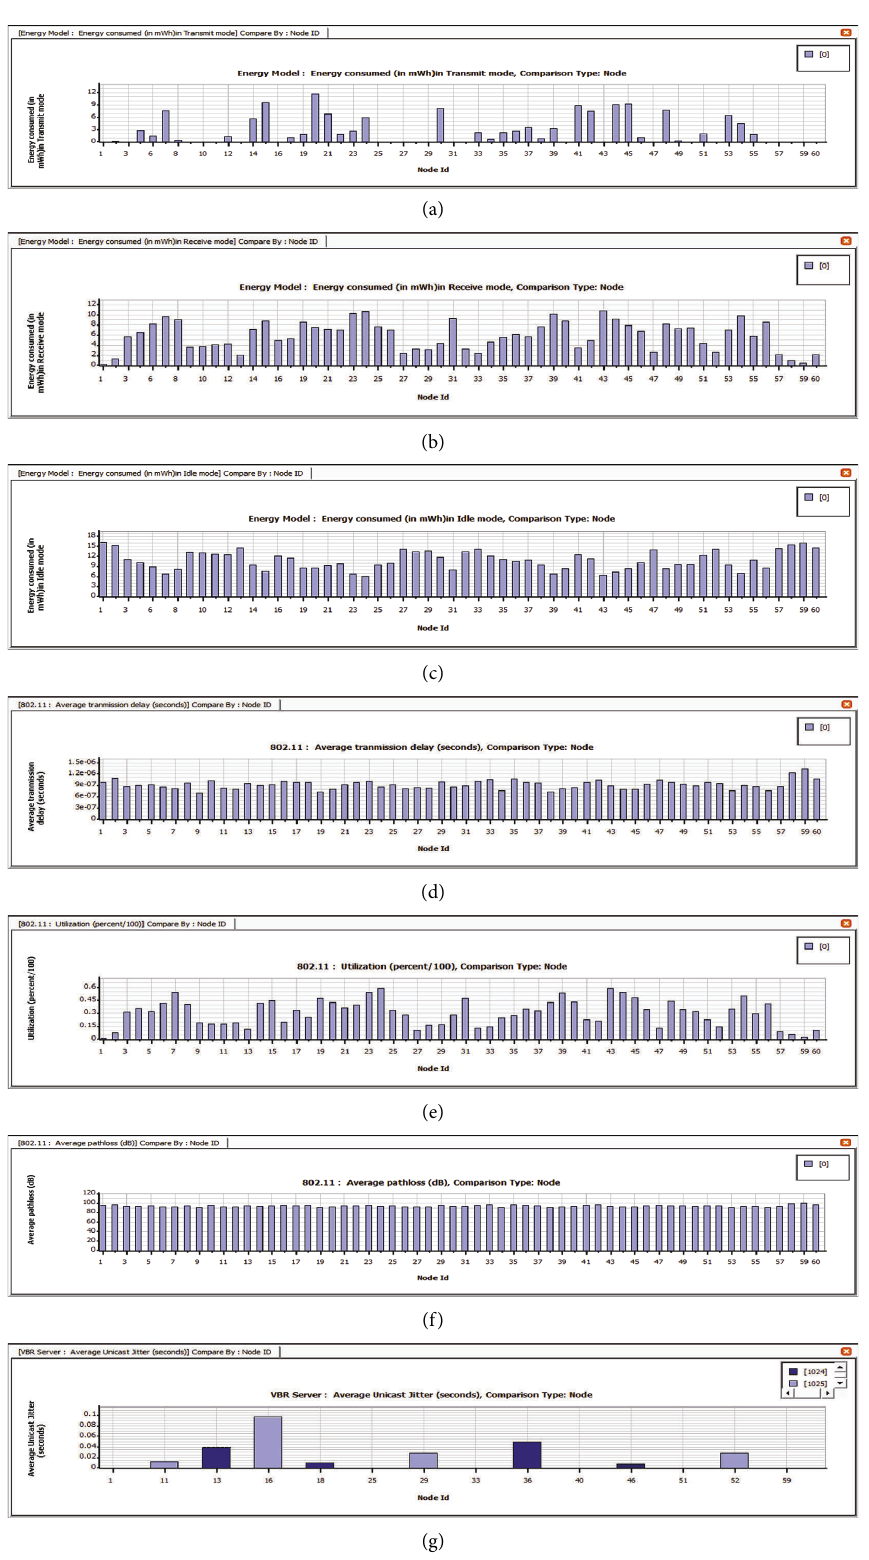
Figure 28: (a) Transmit mode energy consumption of STAR-LORA for VBR deployment. (b) Receive mode energy consumption of STAR- LORA for VBR deployment. (c) Idle mode energy consumption of STAR-LORA for VBR deployment. (d) Average transmission delay of STAR-LORA for VBR deployment. (e) Percentage of utilization of STAR-LORA for VBR deployment. (f) Average pathloss of STAR-LORA for VBR deployment. (g) Average jitter of STAR-LORA for VBR